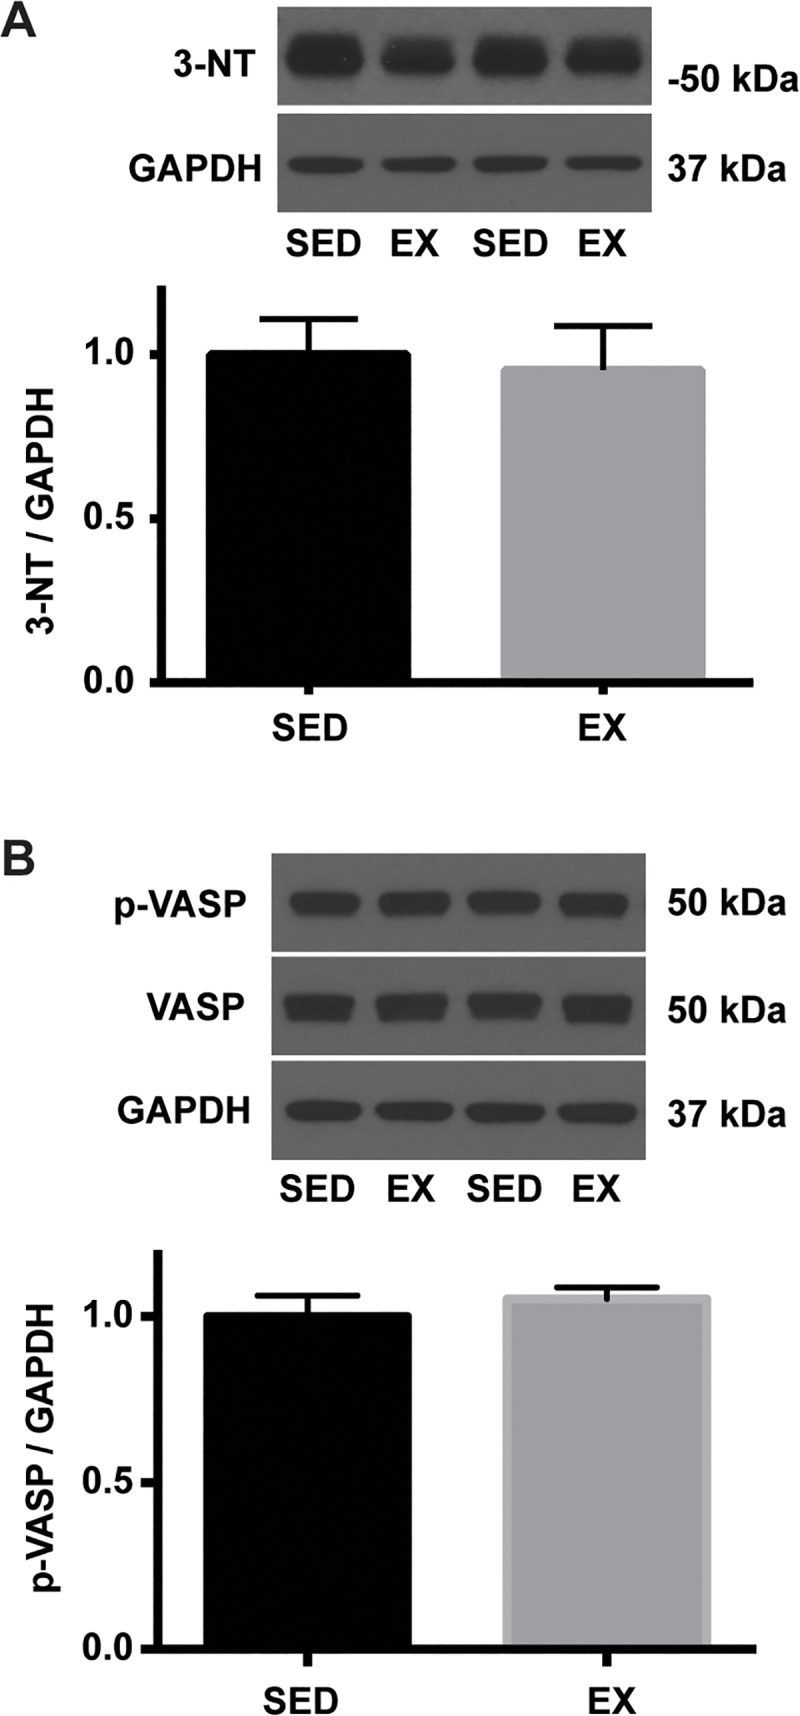
Levels of 3-nitrotyrosine and NO bioavailability in the aortic tissue of SED and EX mice.An equal amount of aortic homogenates was separated by SDS-PAGE. Representative blots are shown above each summary graph. A. 3-nitrotyrosine abundance was normalized to GAPDH and expressed relative to SED mean (n = 7 per group). B. Phospho-VASP (Ser239) level was normalized to GAPDH expression and expressed relative to SED mean (n = 7 per group).